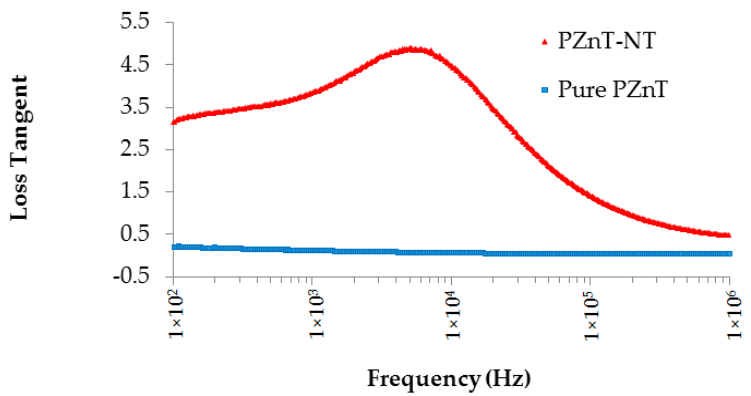
Figure 5. Loss tangent of PZnT-NT.